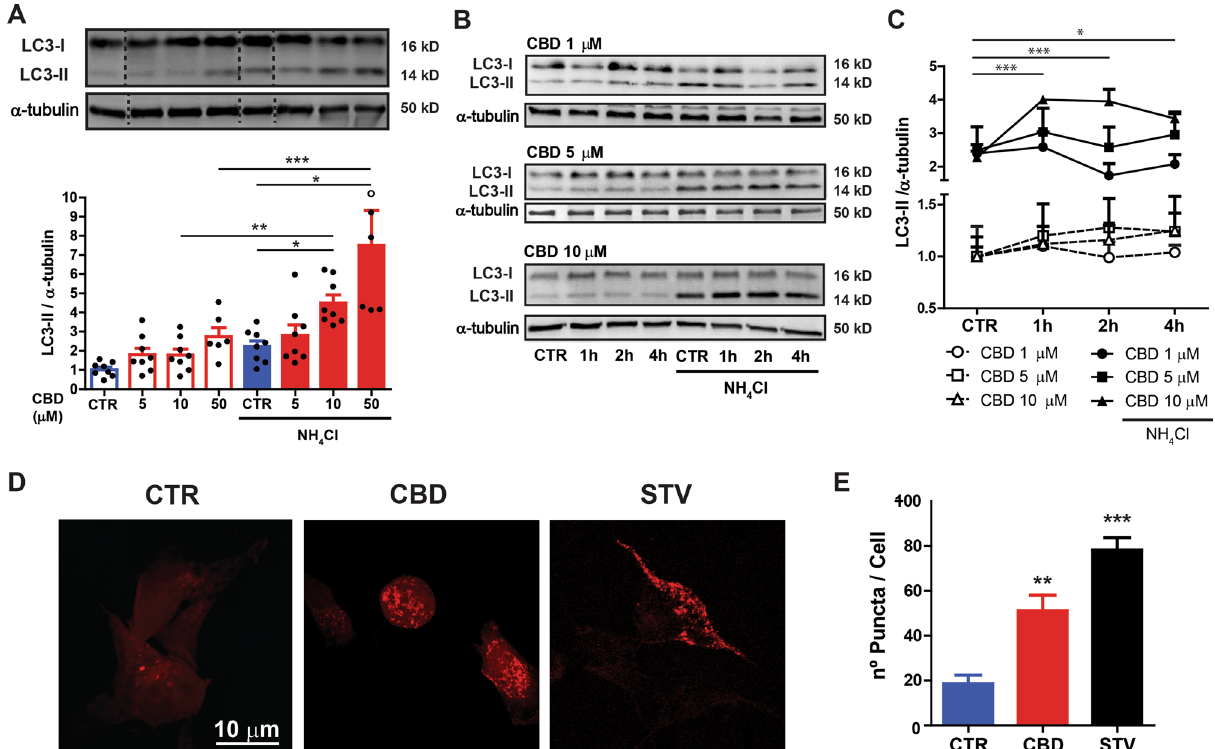
Figure 2. CBD induces autophagy in a concentration-dependent manner. ( A ) The autophagic flux was evaluated in SH-SY5Y cells treated with 5, 10 and 50 µM of CBD for 2 h in the presence or absence of the lysosome inhibitor NH 4 Cl (10 mM) added at the last hour of the treatment. The concentrations of 10 and 50 µM CBD increased LC3-II levels in the NH 4 Cl treated group; Two-way ANOVA ( F 3,52 = 3.499) followed by Sidak’s post-hoc test; * p < 0.05, ** p < 0.01 and *** p < 0.001. ( B ) Time-course for 1, 5, and 10 µM of CBD on the autophagic flux evaluated at 1, 2 and 4 h in the presence or absence NH 4 Cl added at the last hour of the treatment. The concentration of 10 µM CBD increased LC3-II levels after 1, 2 and 4 h of treatment; Three- way ANOVA ( F 6,78 = 3.96) followed by Sidak’s post-hoc test, * p < 0.05 and *** p < 0.001, respectively vs. group treated with NH 4 Cl. Samples were subjected to western blotting using anti-LC3 and anti-α-tubulin primary antibodies. Representative images of LC3-II and a graphical summary reported as the means ± S.E.M of LC3-II levels after α-tubulin normalization are also displayed. ( C ) LC3 puncta count were analyzed in SH-SY5Y cells overexpressing Cherry-LC3 treated with CBD (10 µM) or under starvation conditions (STV) for 2 h. Representative fluorescent images are shown (scale bar, 10 µm). Data are expressed as mean ± S.E.M. One-way ANOVA (